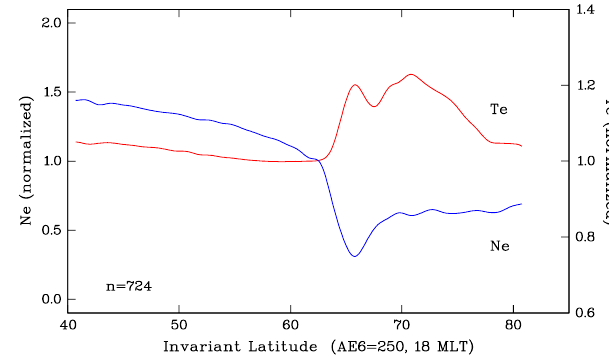
Fig. 10. Mean latitudinal profile of the equatorward trough wall. The median of 724 density profiles is plotted (red curve). These profiles have been superimposed in such a way that the latitude of the poleward boundary of the trough wall latm serves as a com- mon reference location. In addition, all density values of a profile have been normalized to the respective density value observed at the equatorward boundary of the trough wall, Neb . The blue-shaded area indicates the range between the upper and lower quartiles. The latitudes given on the abscissa apply to a geomagnetic activity level of AE 6 = 250nT and a magnetic local time of 18:00h. For other conditions the mean profile should be shifted to higher or lower lat- itudes.